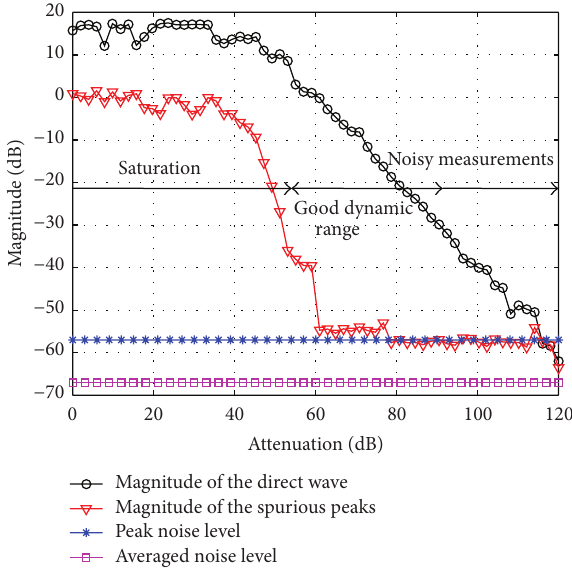
Figure 9: Output power versus input